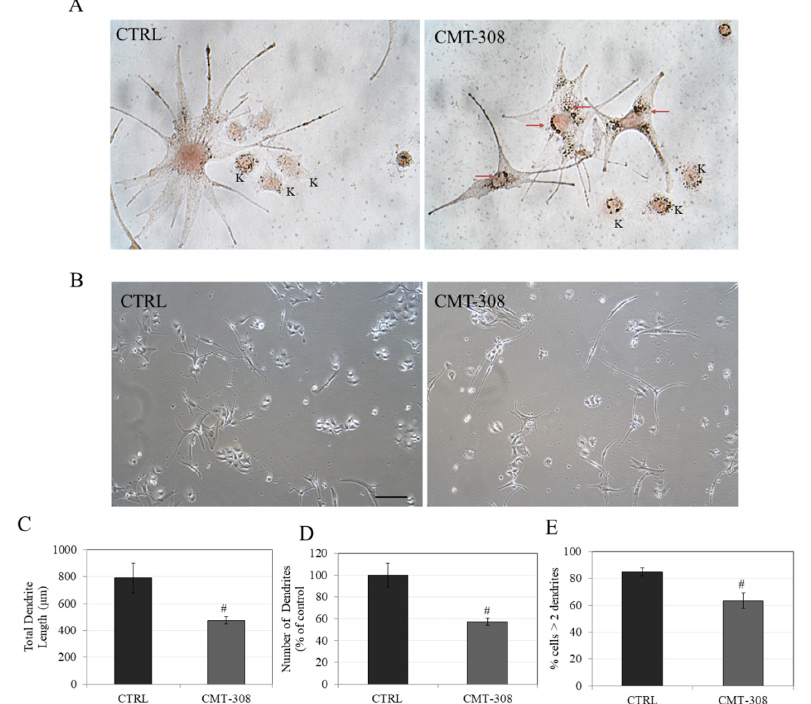
Figure 8. ( A ) Representative Fontana-Masson stained images of HEMn-DP-HaCaT coculture at 40× magnification under bright-field illumination; red arrows show dark-colored melanosomes aggregated around nucleus in CMT-308 (10 µM)-treated group; K: Keratinocytes; ( B ) representative phase-contrast micrographs of cocultures in Ctrl and CMT-308 (10 µM)-treated group; scale bar corresponds to 100 µm ; quantitation of dendricity in cocultures of HEMn-DP: ( C ) Total dendrite length; ( D ) Number of dendrites; ( E ) % cells with >2 dendrites; # p < 0.01 vs. Ctrl, students unpaired t -test; data are mean ± SD from one representative experiment in triplicates; a total of 50–60 cells were counted per group.